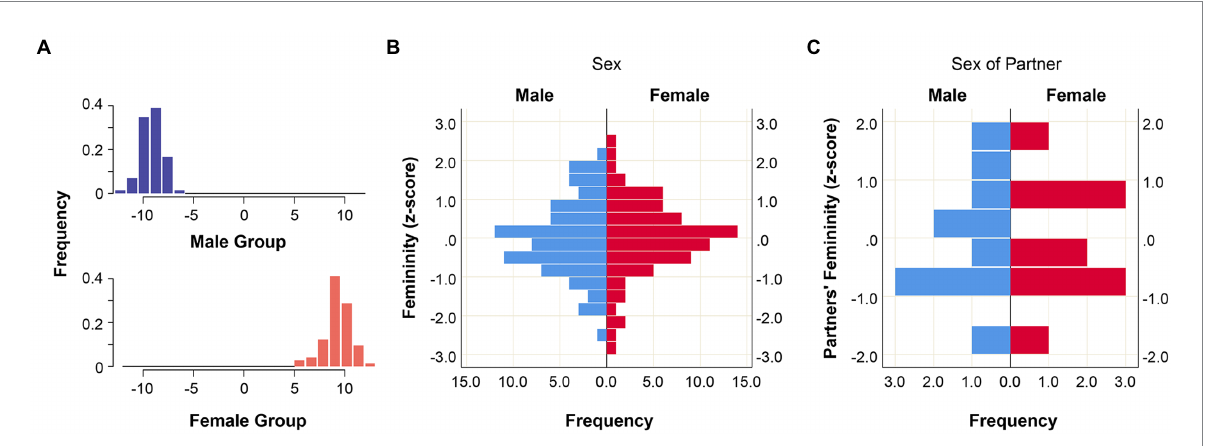
FIGURE 7 Individual facial shape scores by sex. (A) Facial shape scores as a result of linear discriminant analysis of Procrustes facial coordinates by sex; (B) distributions of femininity z -scores after within-sex standardization ( N = 145); (C) distributions of partners’ femininity z -scores after within-sex standardization among partners ( N = 20).